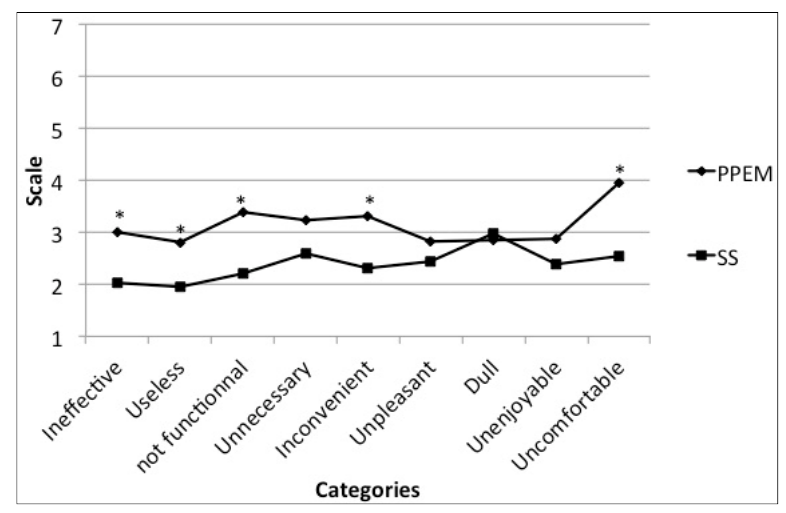
Figure 3. Appreciation of active workstations. Note: Responses were reported on a 1 to 7 scale, where 1 = very favorable and 7 = not favorable at all.